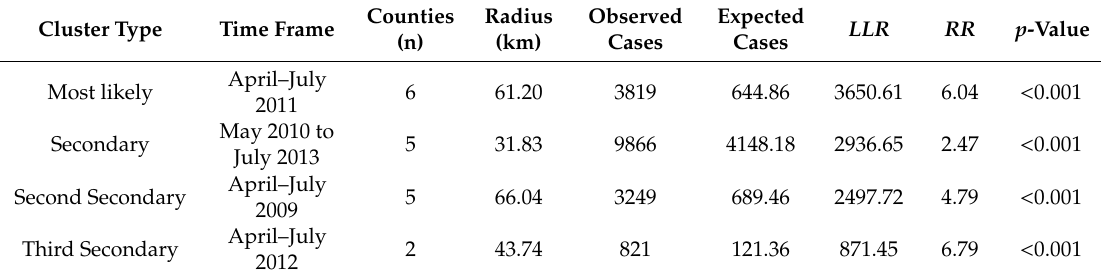
Table 3. Spatiotemporal clusters of mumps cases in Chongqing from 2004 to